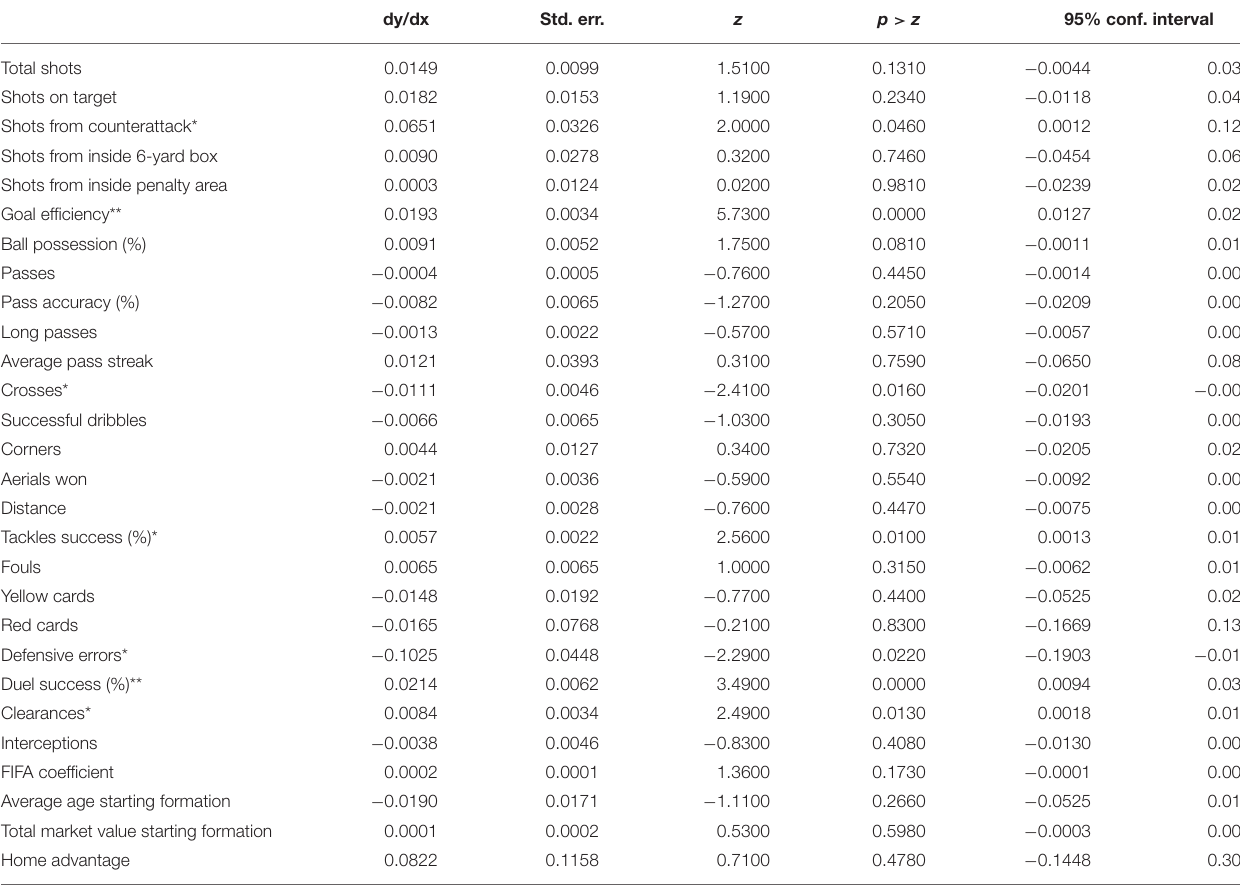
TABLE 3 | Marginal effects for the outcome